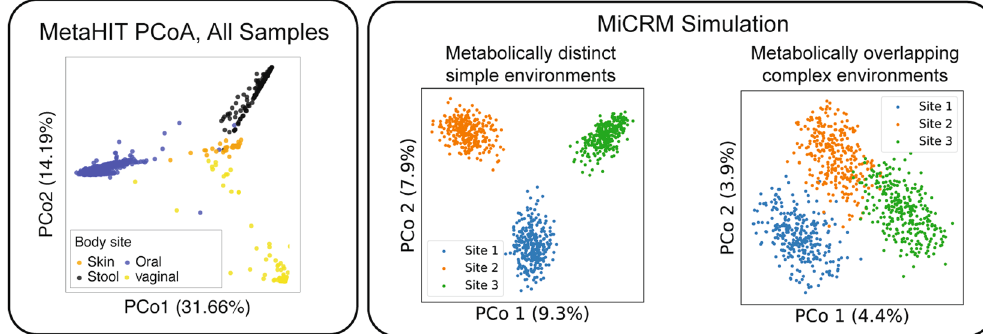
Figure 7. Correlations between inter-site nutrient variation and metabolic structure affect distinguishability of body sites. Left: Principal coordinate analysis (PCoA) of MetaHIT OTU-level community compositions, using the Jensen-Shannon distance metric. Data points are colored by the body site from which the sample was taken. Reproduced with permission from Figure 1 of Ref. 30 . Right: Jensen-Shannon PCoA of species- level compositions of the simulated communities. In the first set of simulations (left), the nutrients supplied to different body sites come from different resource classes. This is the same set of simulations used for the left- hand panel of Fig. 6, but similar results are obtained if the simulations of the other panel are used instead, or if consumption preferences are uniformly random with no taxonomic structure (See Supplementary Fig. S2). In the second set of simulations (right), each environment is supplied with a randomly chosen set of resource types, with each site being supplied with about one third of the 300 possible resources. See main text and Methods for simulation details.